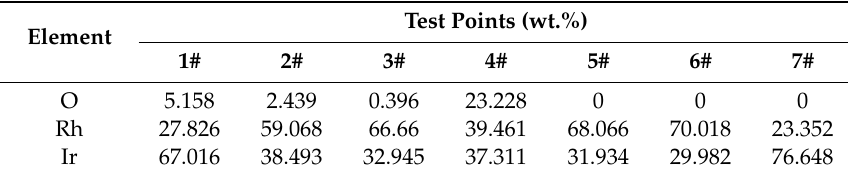
Table 5. EDS analysis results of IrRh25 after oxidation at